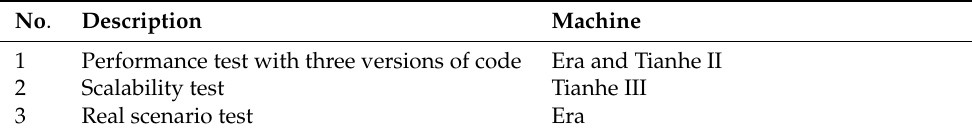
Table 1. Setup of Tests.